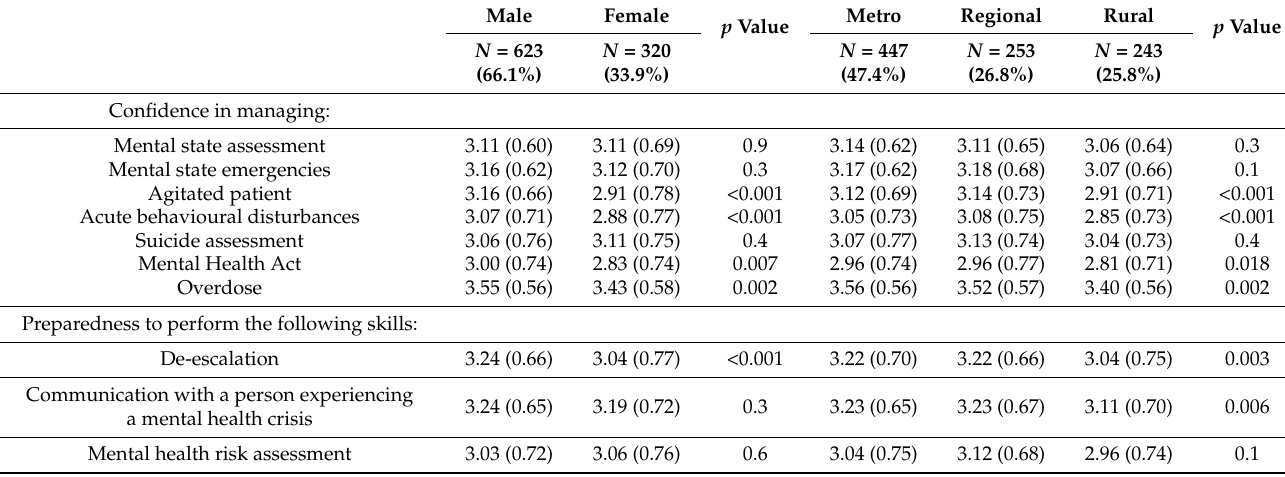
Table 2. Confidence and preparedness by sex and region of practice (scores reported as means and standard